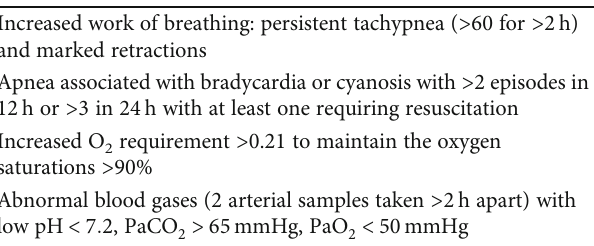
Table 6: Clinical criteria for de fi ning failed weaning from NCPAP (at least 2 of the